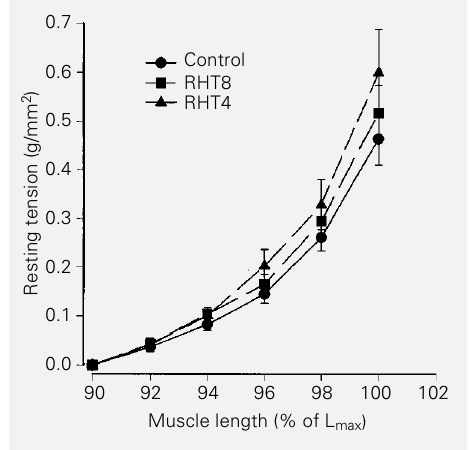
Figure 1 - Passive length-tension relations for renovascular hyper- tension at 4 (RHT4 group) and 8 weeks (RHT8 group) and for con- trol rats (control group). Results are reported as means ± SD. The curve for the RHT4 group was significantly different from the curve for the control group (P<0.05) (nonlinear regression modeling comparing parameters estimated by the residual sum of squares, F ratio test). The shift to the left indicates increased myocardial passive stiffness. L max : muscle length at peak of developed